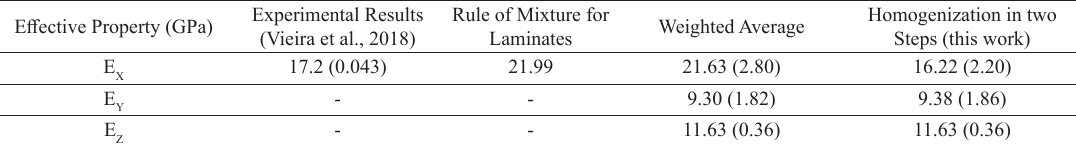
Table 9. Comparison between the experimental results and the Rule of Mixture for laminates with the results obtained in this work (CoV in parenthesis). Experimental Results Effective Property (GPa) (Vieira et al.,